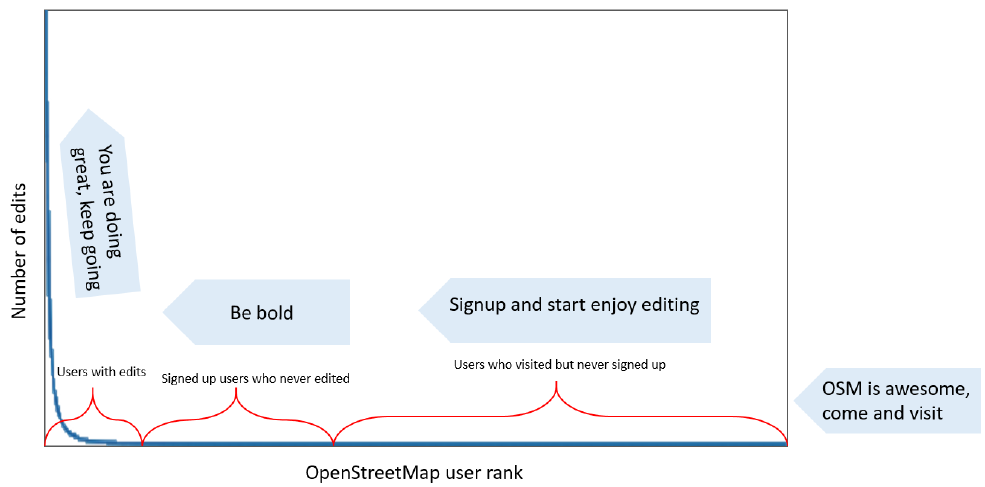
Figure 3. How to encourage users to contribute to OpenStreetMap? Adapted from Wood’s analysis [37]. The figure shows the need to use various ways to motivate each group of potential volunteers to contribute to OpenStreetMap. The steps (from right to left) include encouraging people to visit OpenStreetMap, then encouraging them to sign up and make contributions, and finally, to keep the active contributors motivated and engaged.